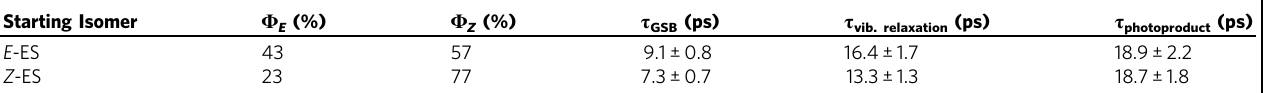
Table 1 Photoisomerization quantum yields and time constants in acetonitrile solution extracted from TVAS fi tting. Starting